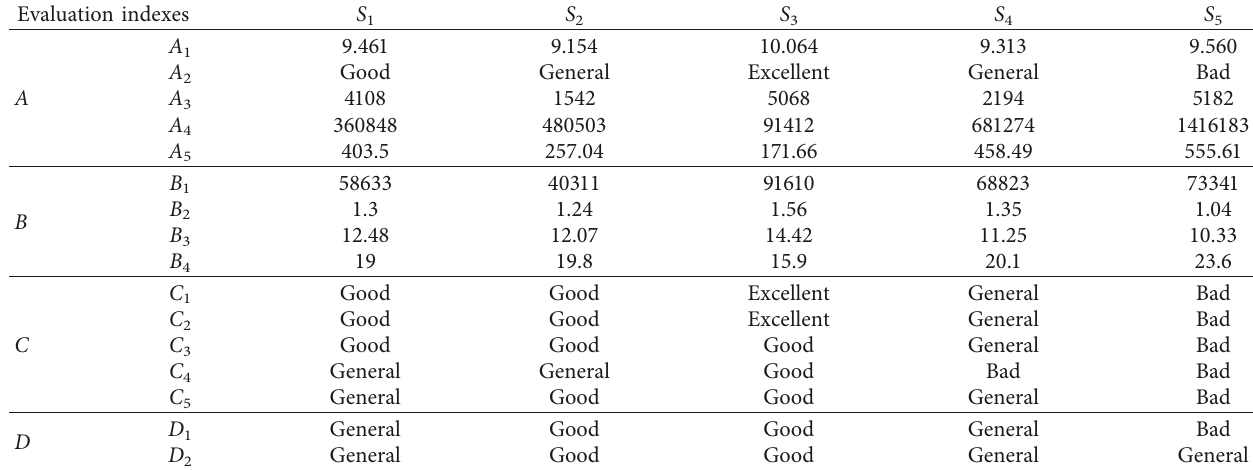
Table 3: The evaluation indexes of five